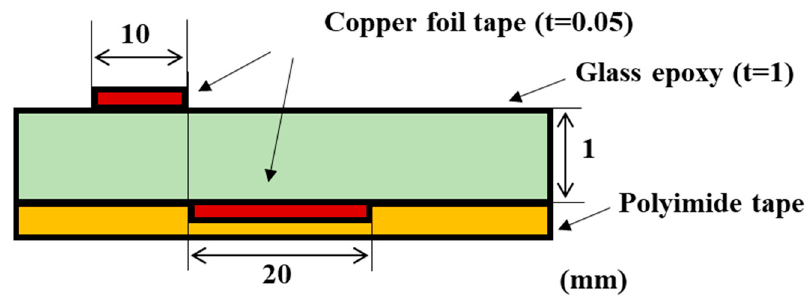
Figure 4. Dimensional configuration of the DBDPA.